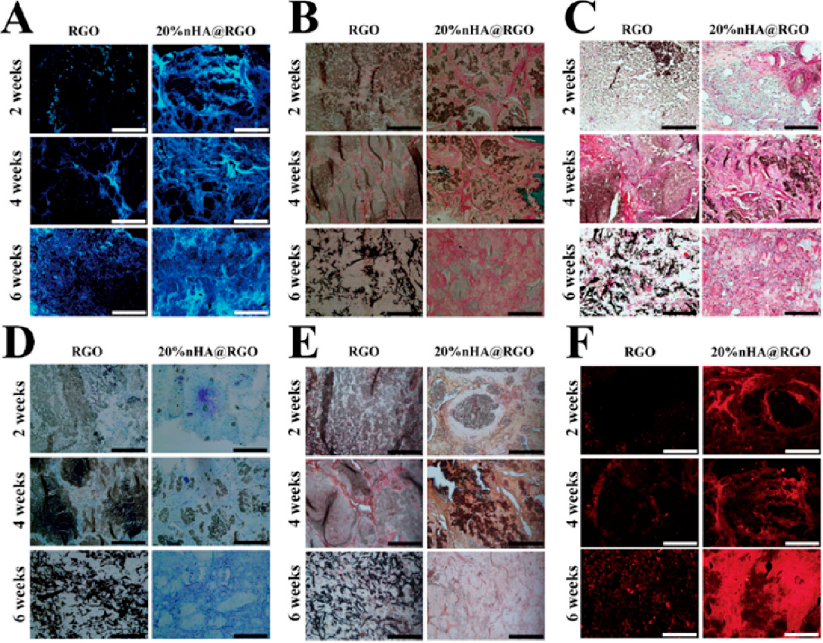
Figure 5. Proliferation, osteogenic gene expression and ALP activity of rat bone mesenchymal cells ( A ) DAPI; ( B ) Goldner’s; ( C ) Masson’s trichrome staining; ( D ) Toluidine Blue; ( E ) alkaline phosphatase (ALP); ( F ) OCN [71] (copyright 2017, Carbon).